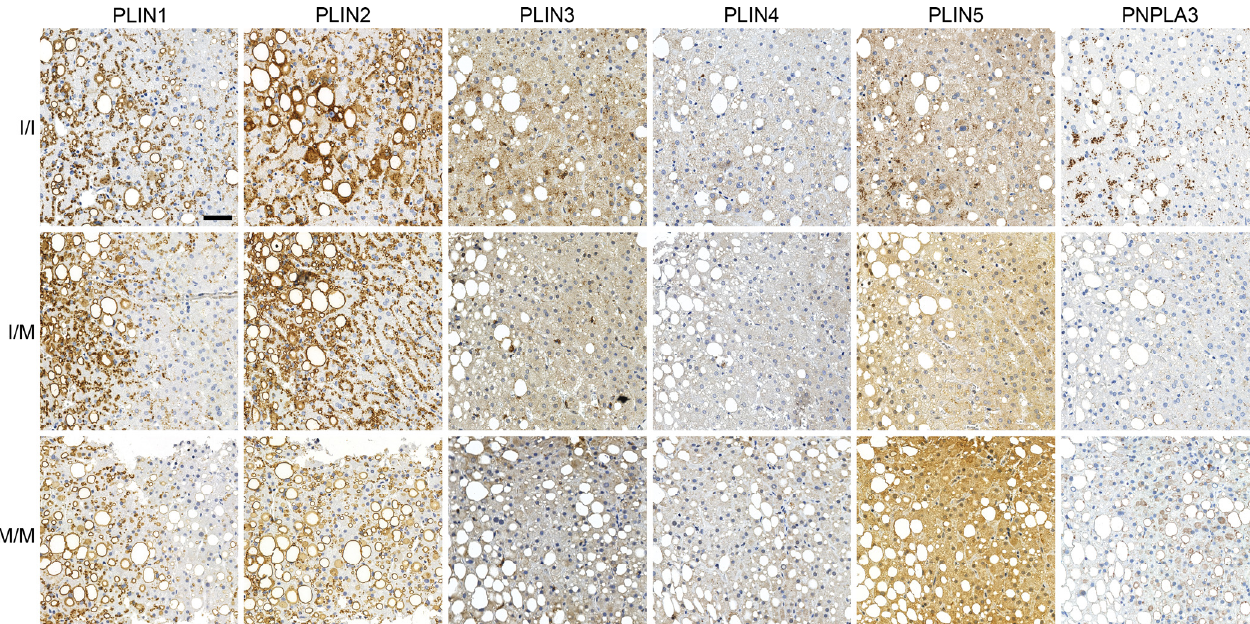
Figure A2. Reduced perilipin 1, 2 and 3 staining in livers of NASH patients carrying the homozygous PNPLA3(I148M)-polymorphism. Immunohistochemical analysis of perilipin 1-5 and PNPLA3 in a collective of 23 liver biopsies from NASH-patients with known PNPLA3-status as shown in Figure 1. Please note PLIN3 and PLIN4 immunohistochemical stainings, which are not shown in the main Figure 1A. Scale bar: 50 µm.